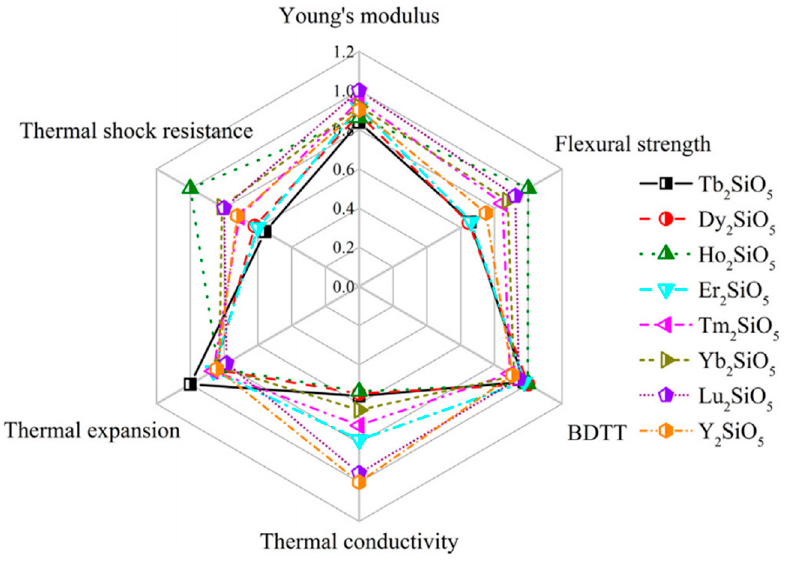
Figure 9. Radar chart for comparison of the properties of X2-RE 2 SiO 5 [139].